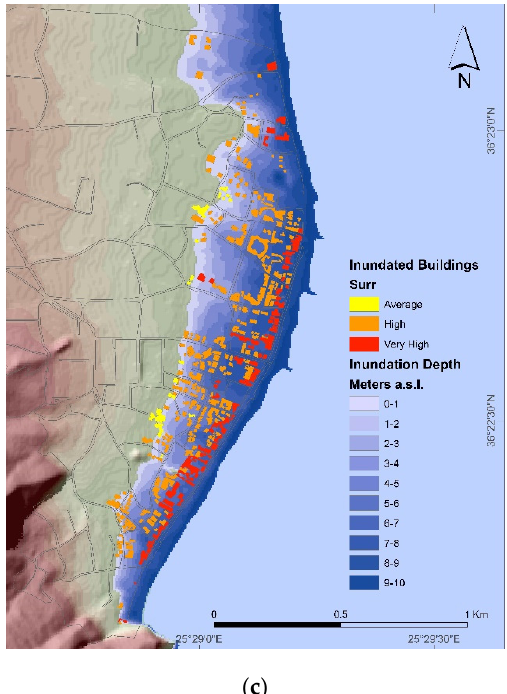
Figure 6. Maps depicting the spatial distribution of: ( a ) building vulnerability (Bv); ( b ) exposure (Ex); ( c ) surrounding characteristics (Surr) components.